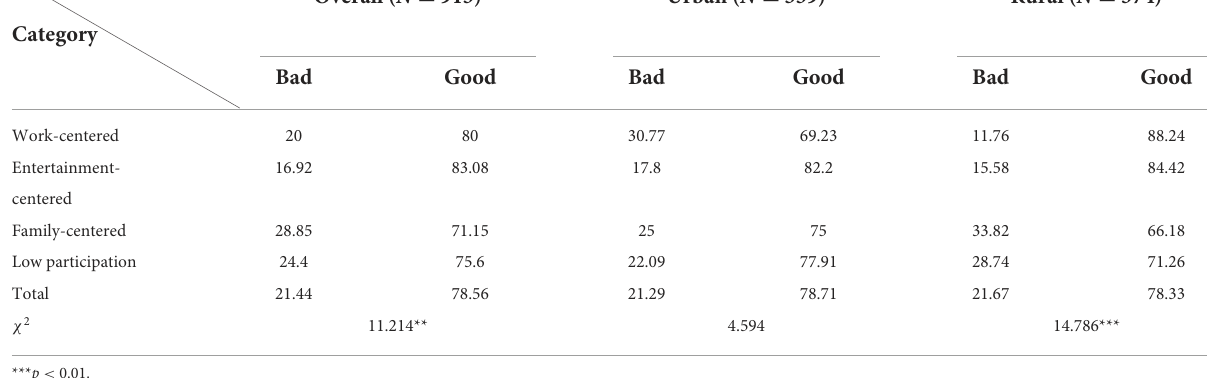
TABLE 7 Memory differences in the elderly with social participation patterns. Memory (%)